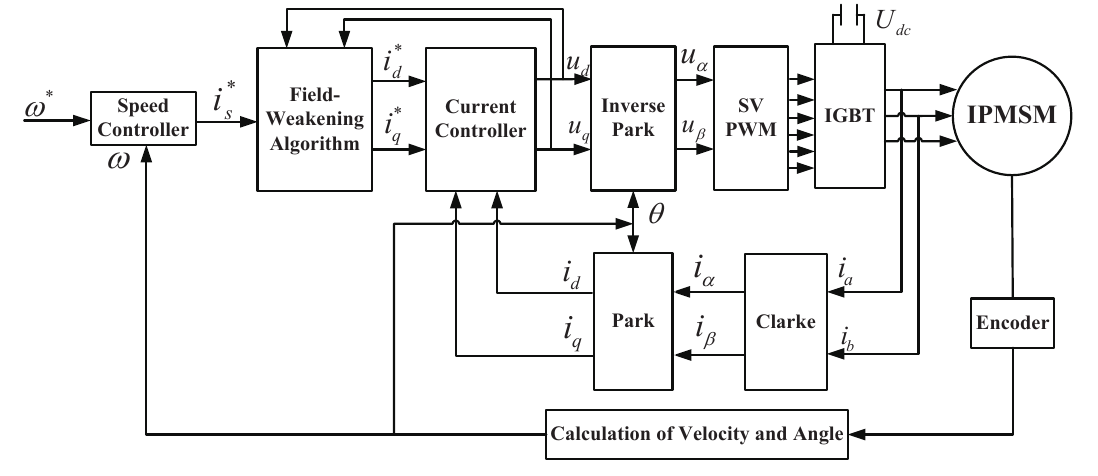
Figure 1. Block diagram of the interior permanent magnet synchronous motor (IPMSM) flux-weakening cascaded control